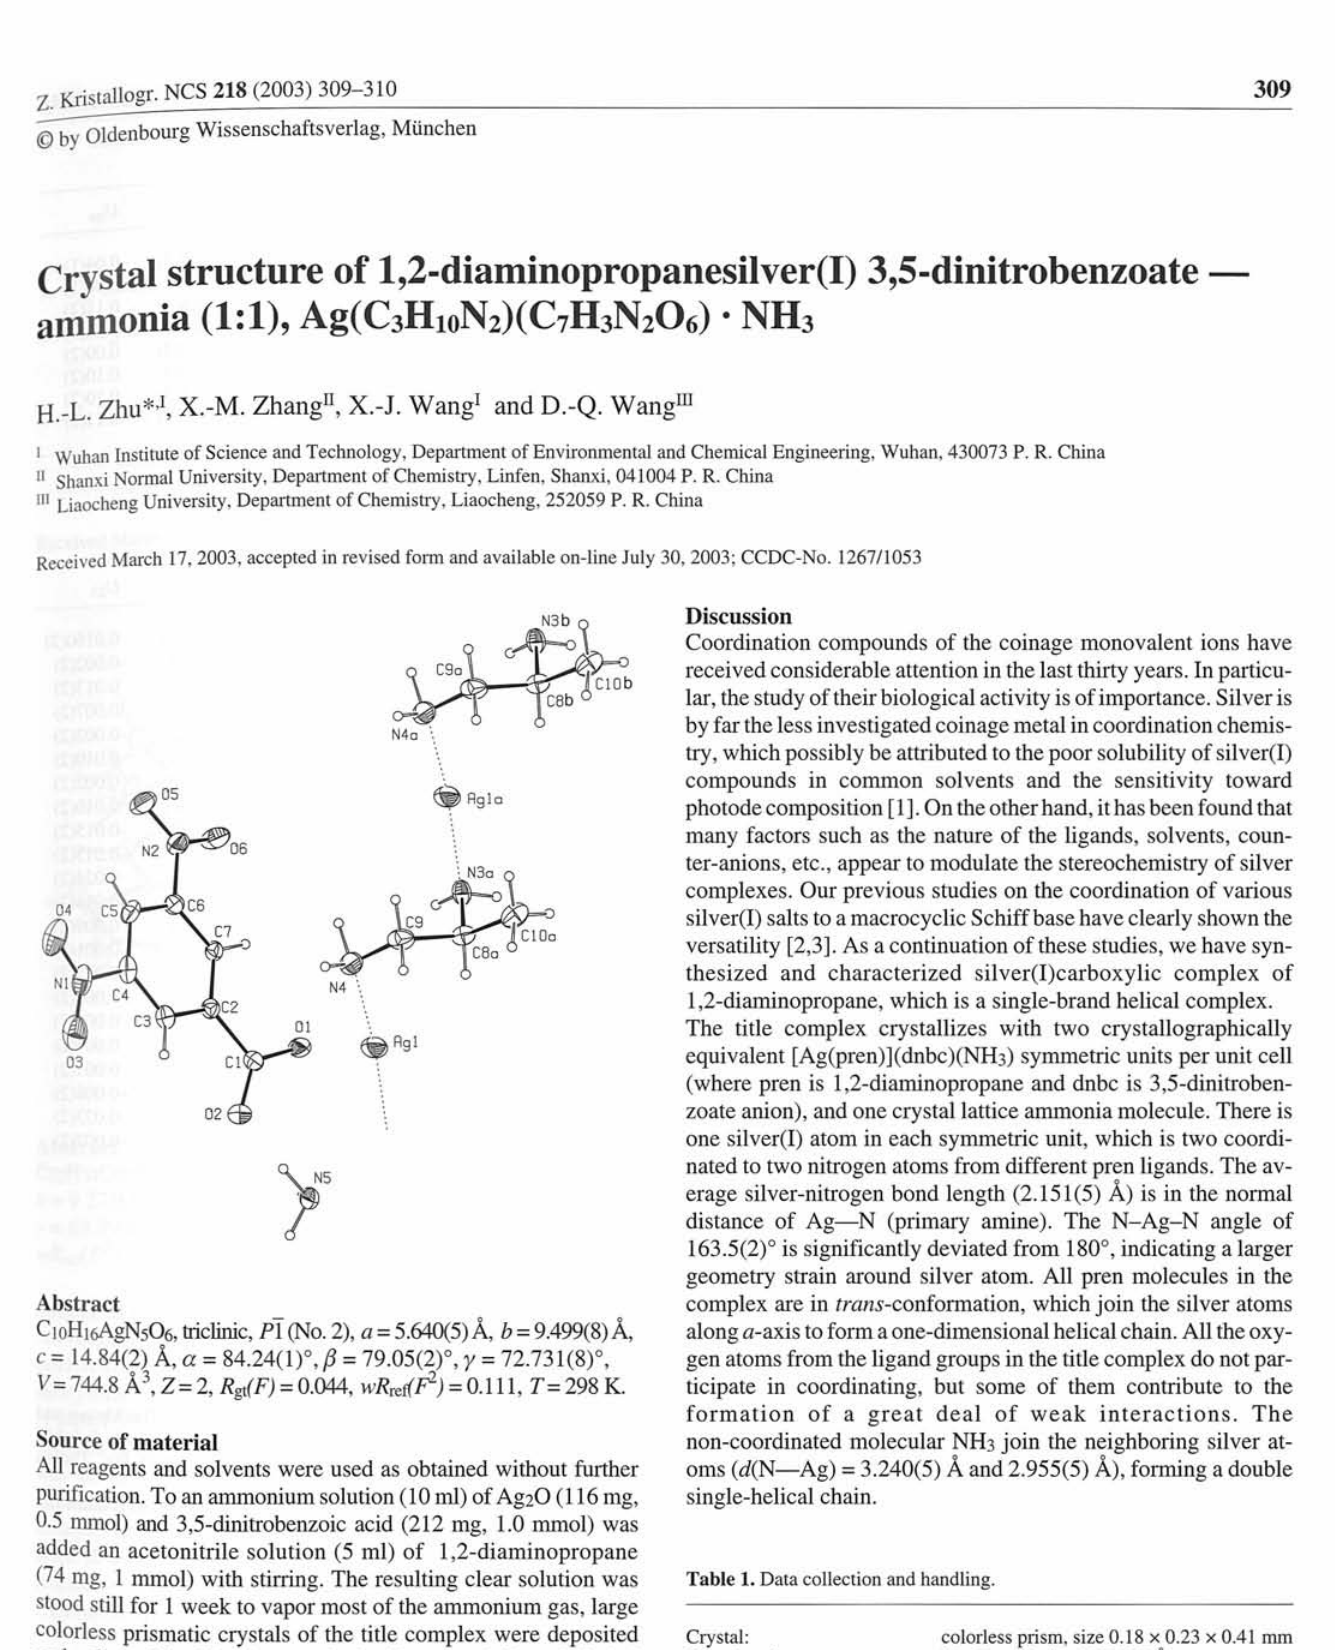
Table X. Data collection and handling.